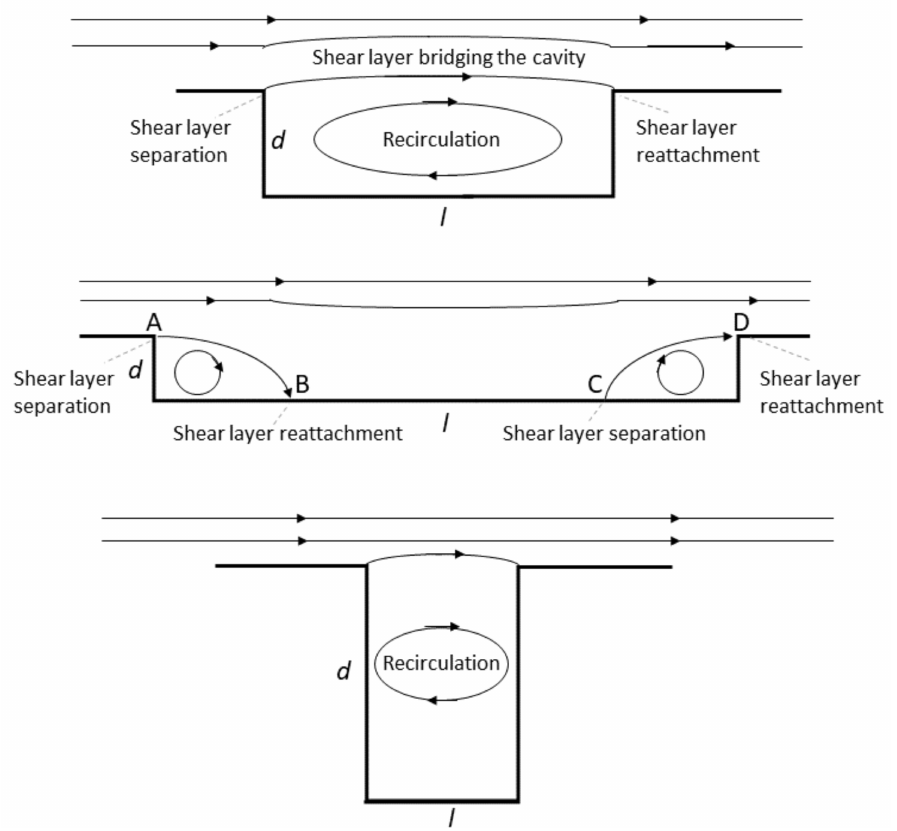
Figure 1. Schematization of the flow types within a